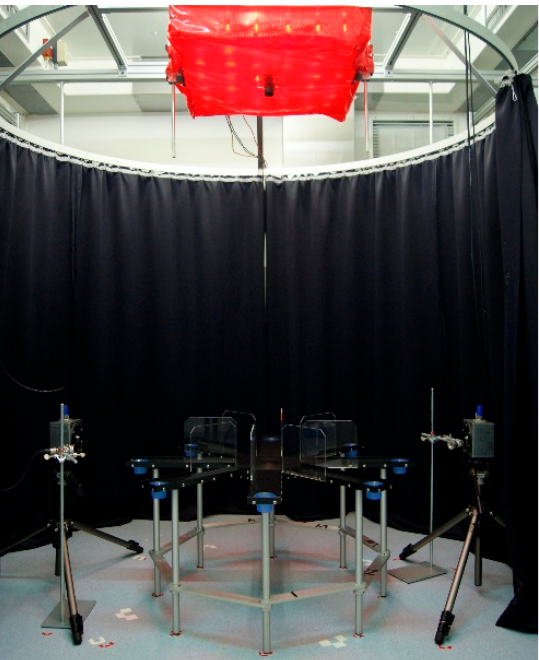
Figure 2. Photograph of the radial eight ‐ arm maze used for playback. For details see text. Please note that the photo was taken under conditions of bright light for better visibility of technical details, whereas the tests were always conducted under red light conditions.